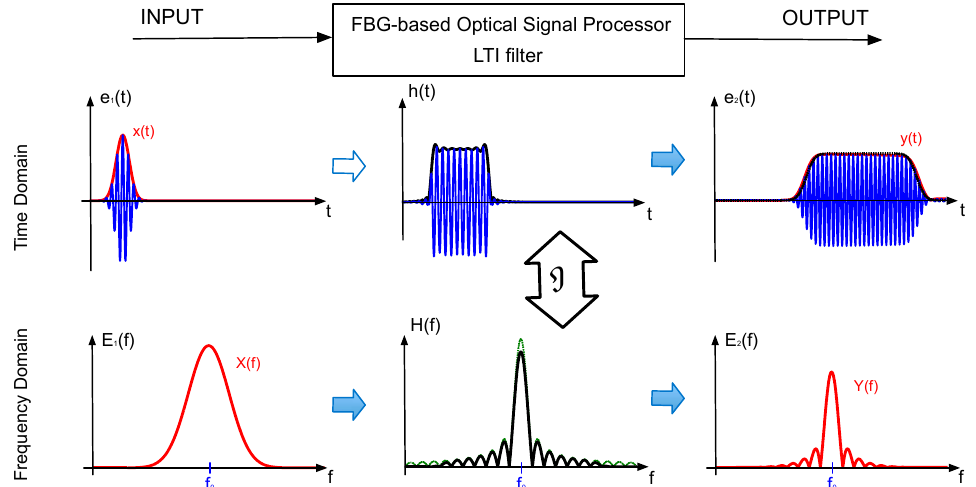
Figure 5. Diagram for the principle of operation of an FBG-based optical signal processor in both time and frequency domains. e i ( t ) and E i ( f ) , with i = 1, 2, stand for optical fields in the time and frequency domain, respectively.